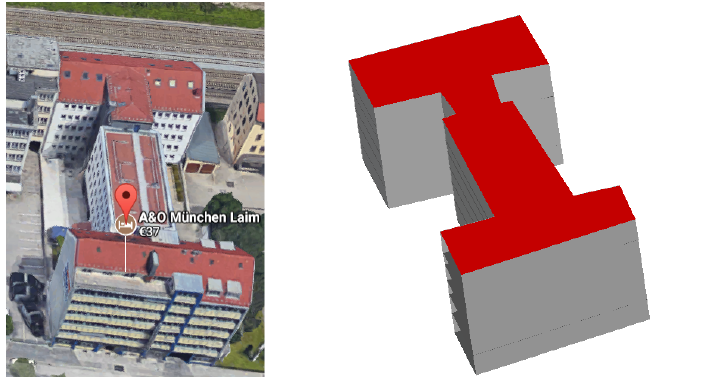
Figure A1. Final CityGML level of detail two plus (LoD2+) model for the TUM main campus building.